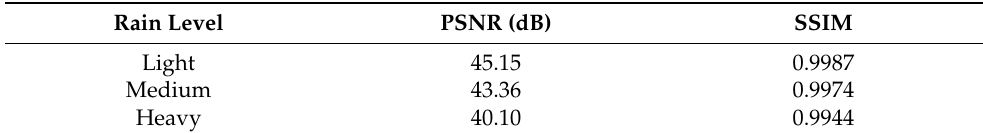
Table 4. Comparison of the average values of PSNR (in dB) and SSIM of the reconstructed light, medium, and heavy rainy images.